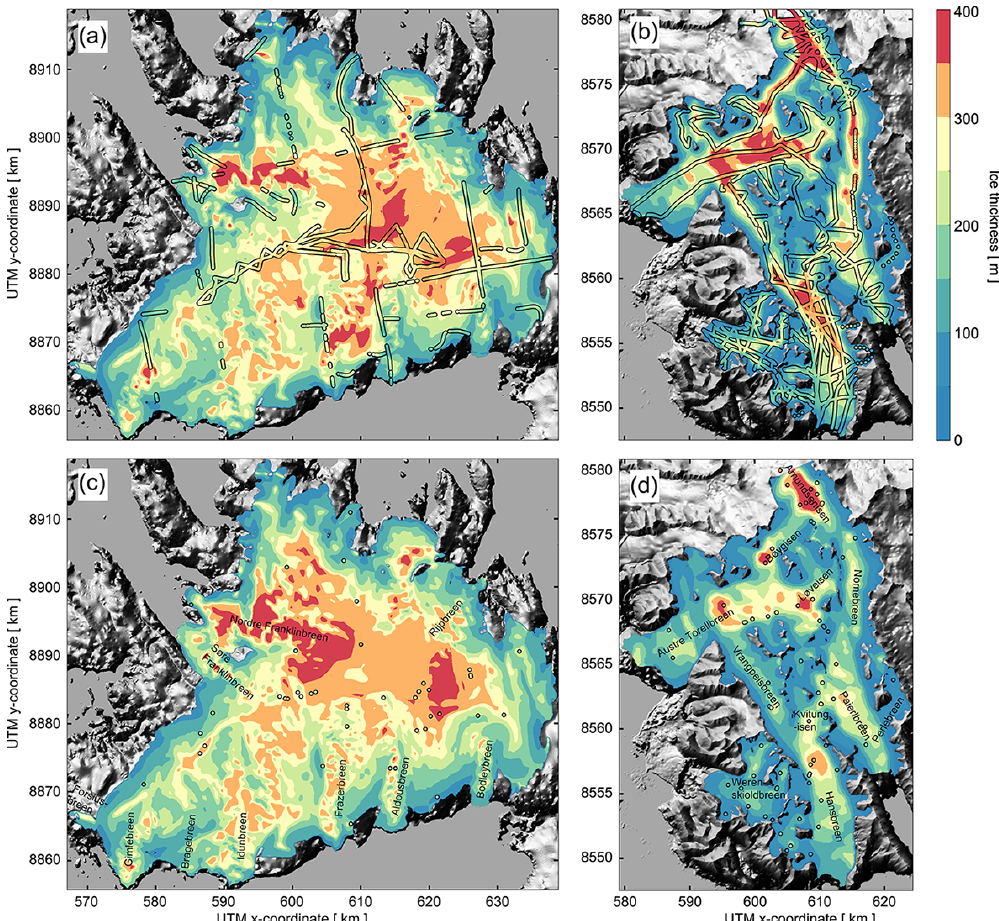
Figure 4. First-step ice-thickness map for VIC (a, c) , THPB and WSB (b, d) accounting for thickness measurements. Thickness values for marine ice fronts are non-zero and a natural outcome of the underlying mass budget calculation. For VIC, thickness measurements (coloured dots) were collected with airborne radio-echo sounding instruments (Dowdeswell et al., 1986) as well as with ground-based pulsed radar systems (Pettersson et al., 2011; Navarro et al., 2014). For THPB and WSB, measurements were collected during several GPR campaigns between 2004 and 2012 (Navarro et al., 2014). The upper (a, b) and lower (c, d) panels show the respective thickness fields when all or only 1% of all thickness measurements were used in the first-step reconstruction, respectively. For the ice cap, mean thickness values are not very sensitive to the data availability, whereas the not well constrained reconstruction for THPB and WSB produces low biased estimates. Background: grey-scale hill-shaded topography based on a NPI 50m DEM (http://publicdatasets.data.npolar.no/kartdata/NP_S0_DTM50.